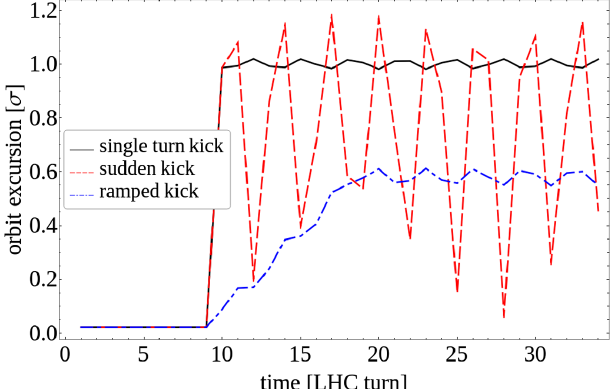
FIG. 3. Comparison of the orbit excursion over time for three different types of kicks. The kick strength in all cases is 1 σ . For the solid line, the kick was present only on one single turn. For the dashed-dotted line, the kick was ramped over ten turns and then remained constant, while for the dashed line the kick was switched to maximum strength in one turn and then remained